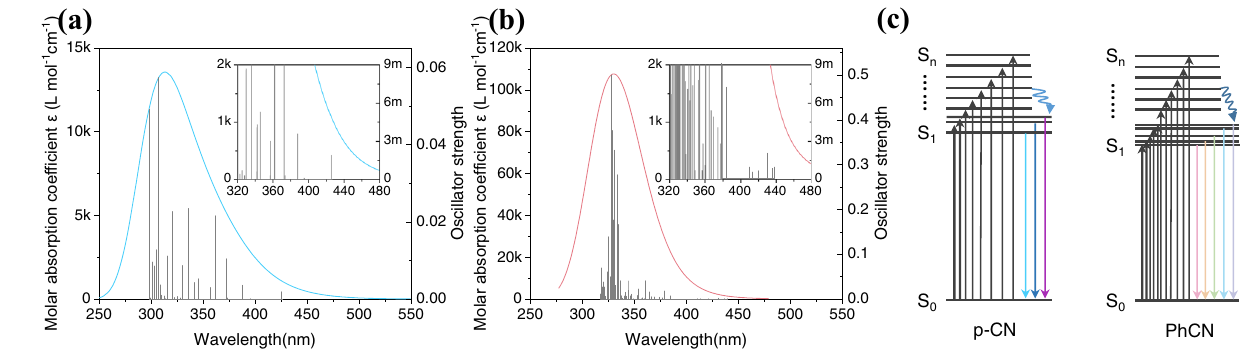
Fig. 4 | DFT calculations. The DFT-calculated oscillator strength and molar absorption coef fi cient of a p-CN and b PhCN (inset: enlarged detail). c Schematics of the excitation and de-excitation processes in p-CN and PhCN. S 0 , S 1 , and S n